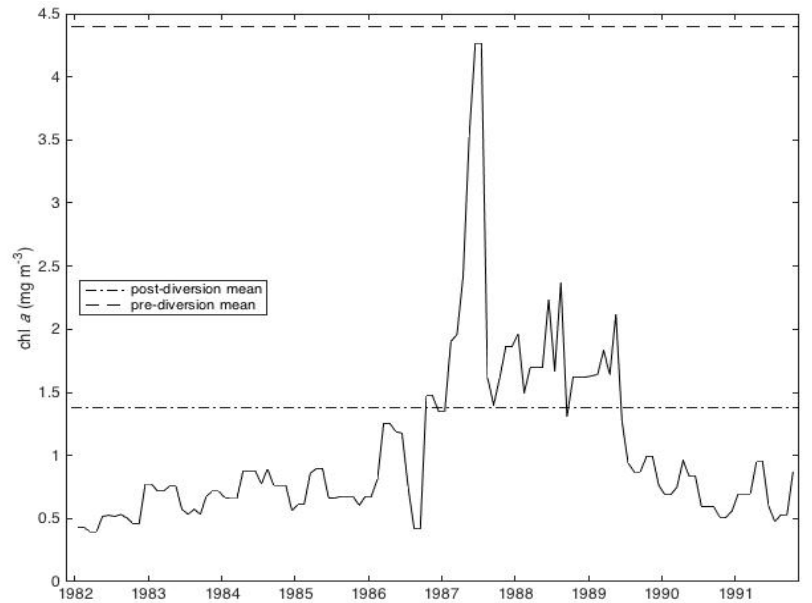
Figure 2. The three-month running means of chlorophyll a concentrations in the southeast sector of Kaneohe Bay from the middle of 1982 until the middle of 1992. Tick marks indicate the midpoint of the indicated year.